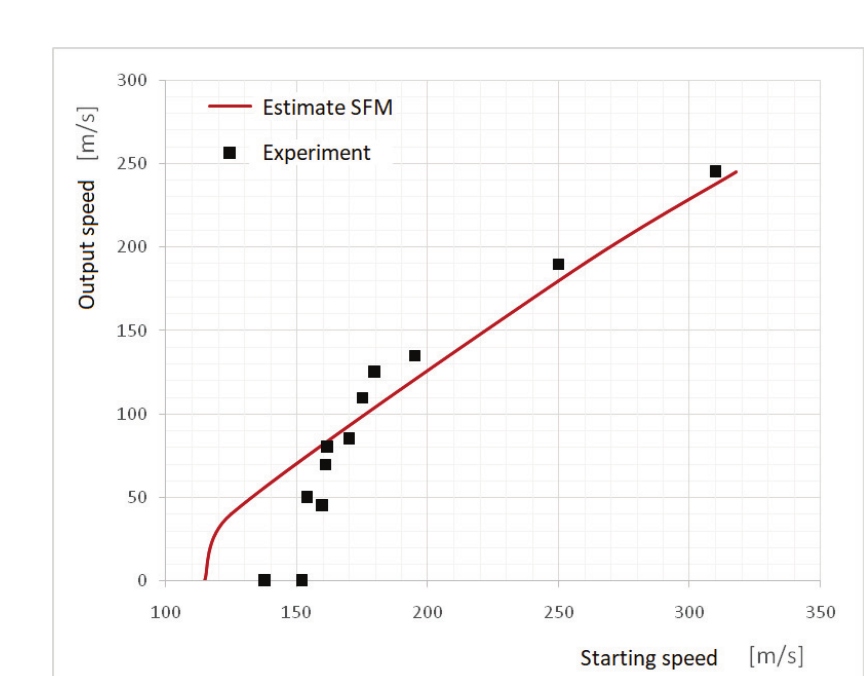
Figure 7 – Analysis of the SFM by a blunt projectile for a plate with a thickness of 8 mm Рис . 7 – Анализ SFM тупоконечным снарядом на плиту , толщиной 8 мм